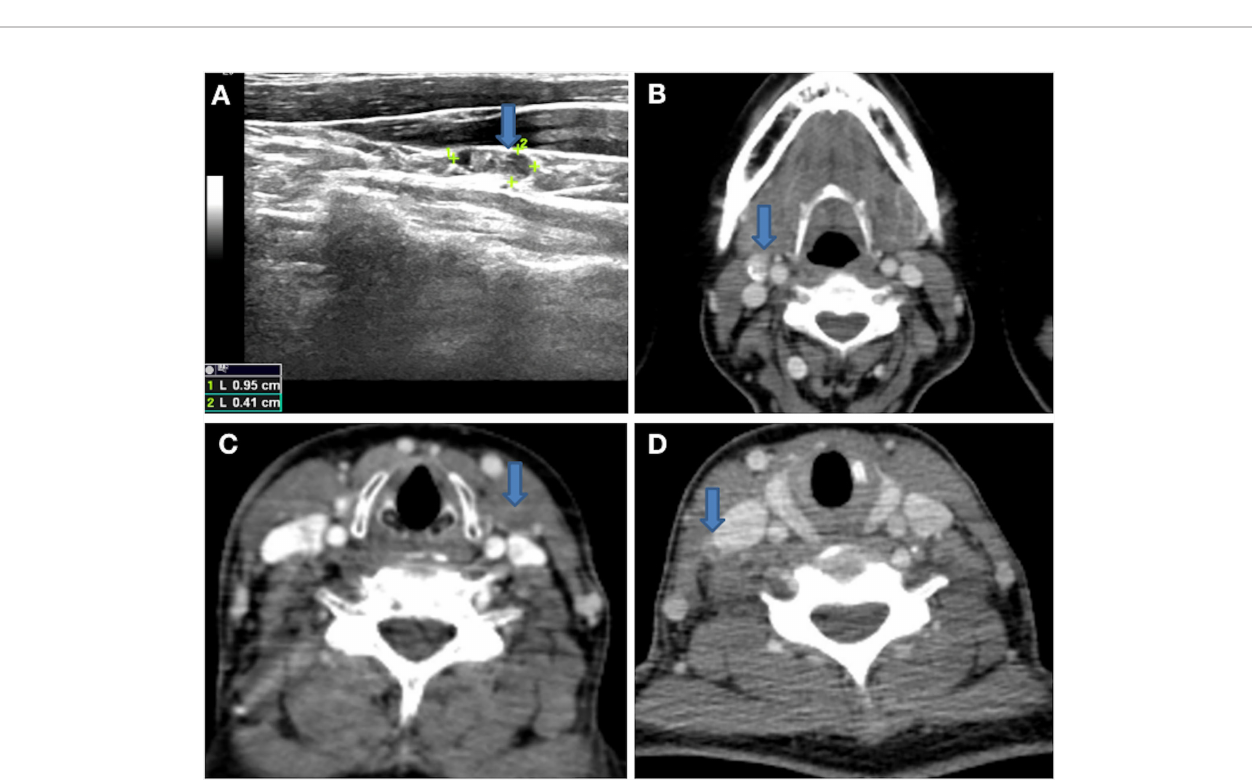
FIGURE 1 | (A) Lateral neck lymph node with microcalci fi cation on high-resolution US. (B) Lateral neck lymph node with microcalci fi cation on 1-mm thin layer contrast-enhanced CT. (C, D) Lateral neck lymph nodes with low-density or liquid components on 1-mm thin layer contrast-enhanced CT.